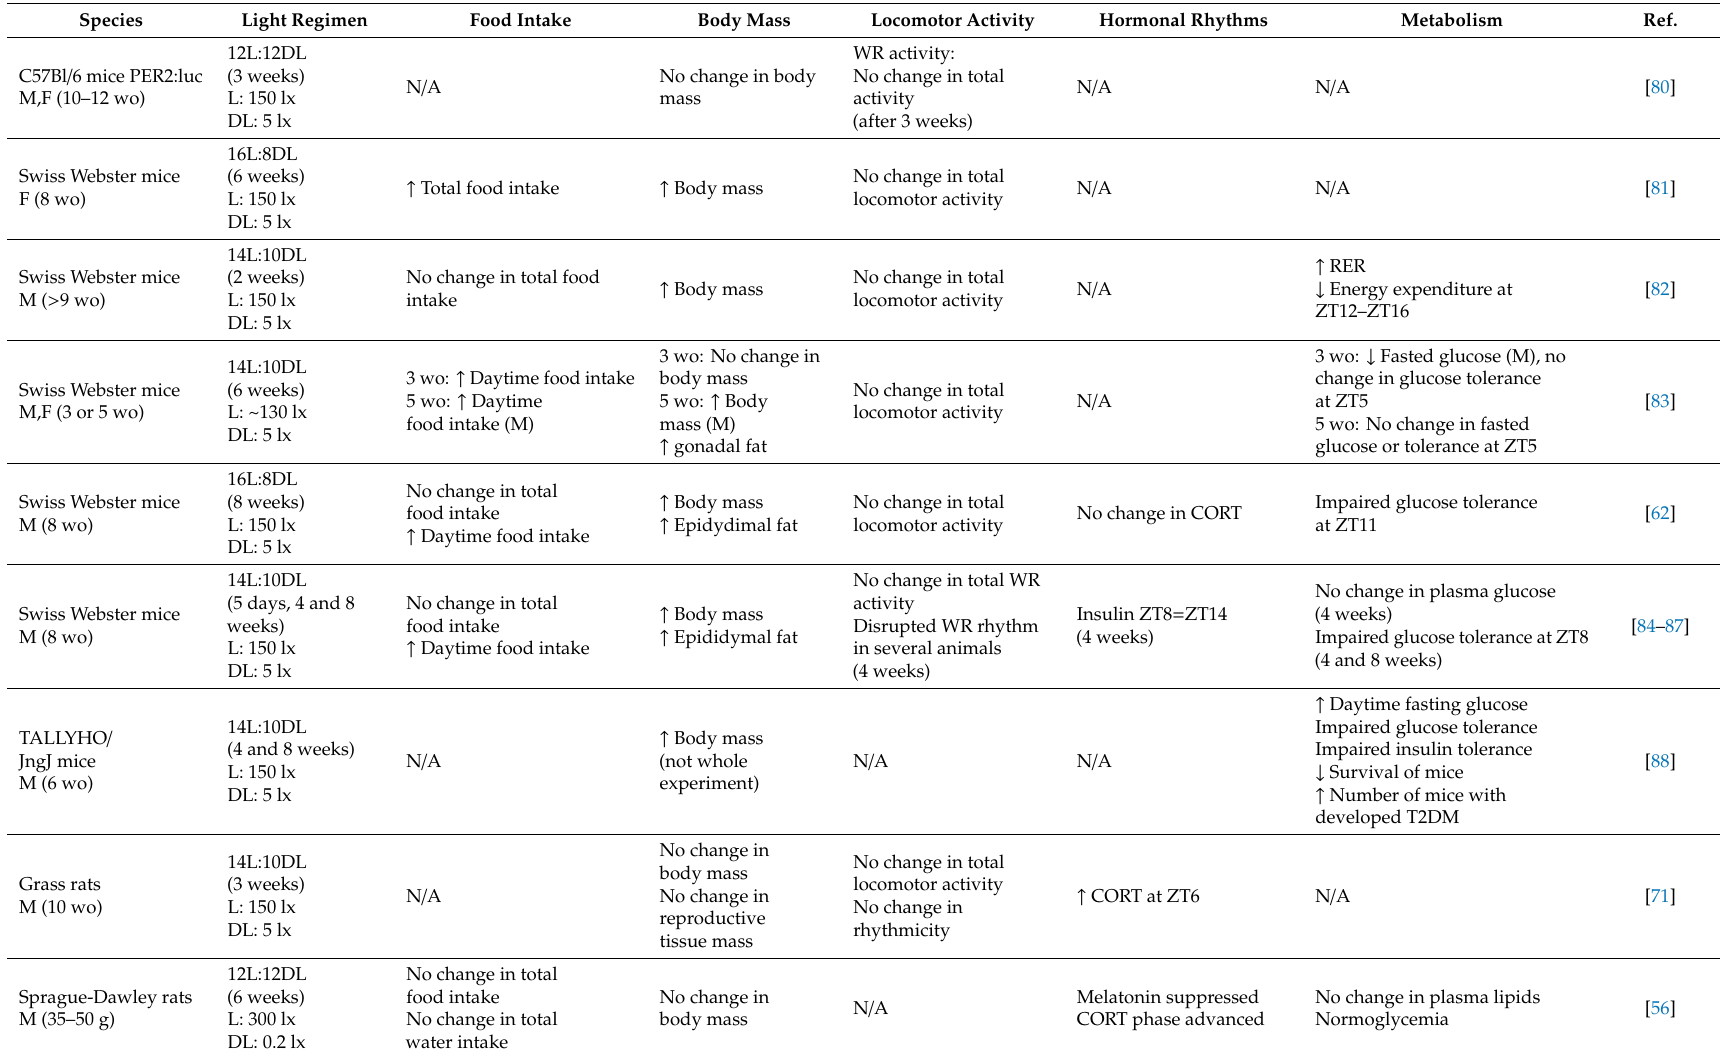
Table 2. E ff ects of dim light at night (dLAN) on the behavior and physiology of mice and